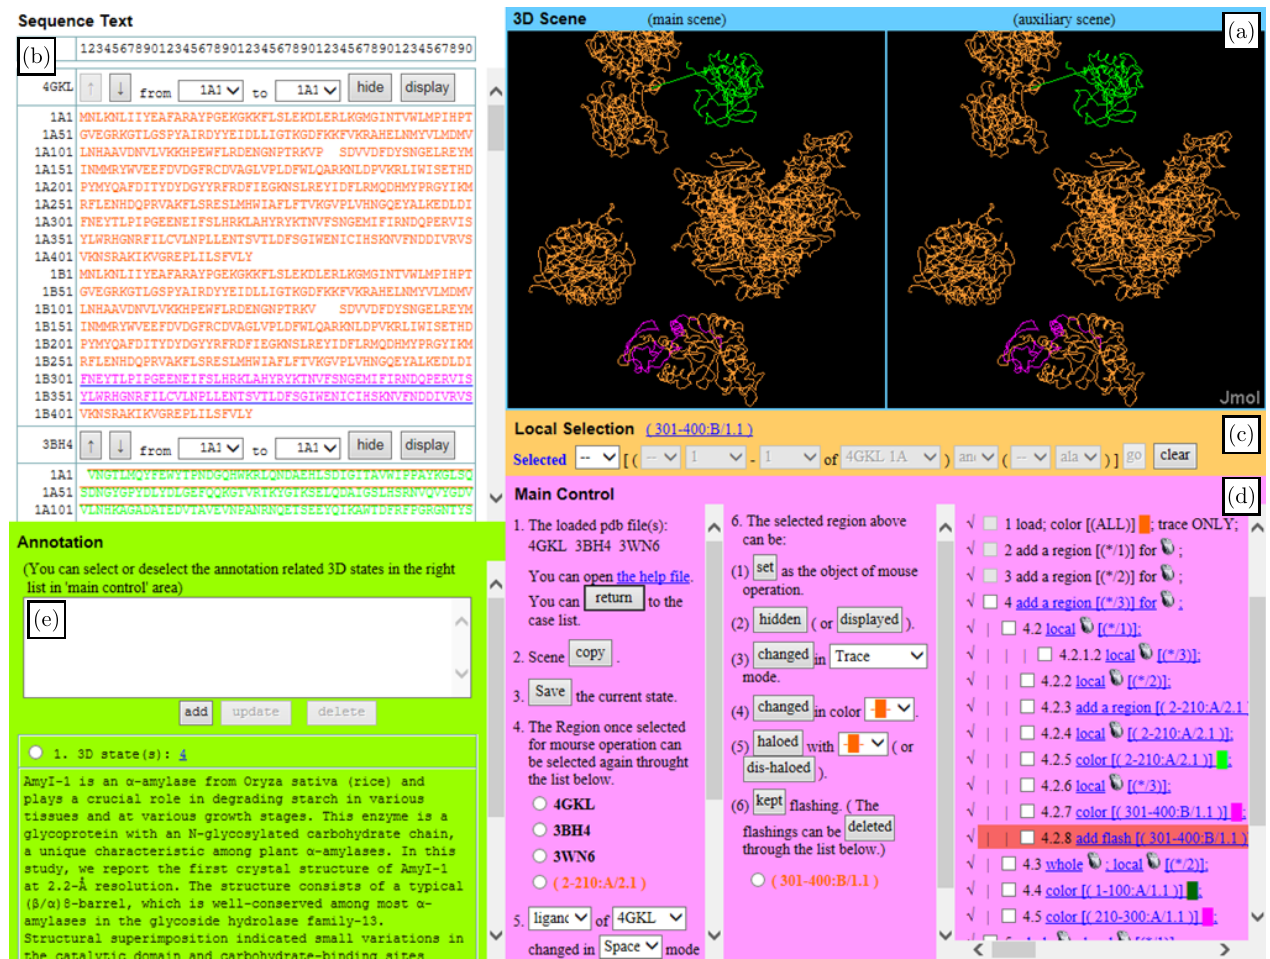
Fig. 3. Main user interface of PDBlocal. (a) \3D scene" area. (b) \Sequence Text" area. (c) \Local Selection" area. (d) \Main Control" area. (e) \Annotation"